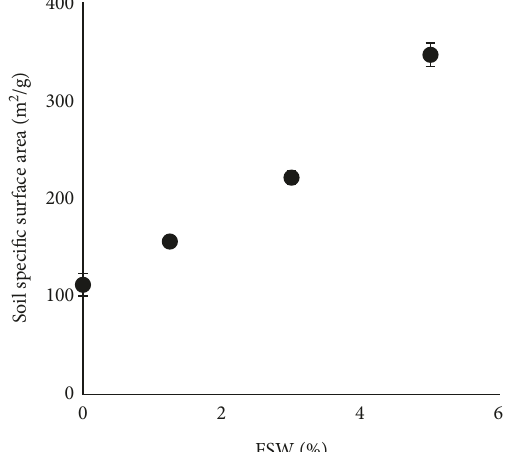
Figure 4: A scatter diagram showing a linear relationship between the FSW and the specific surface area of the soil at the 120th